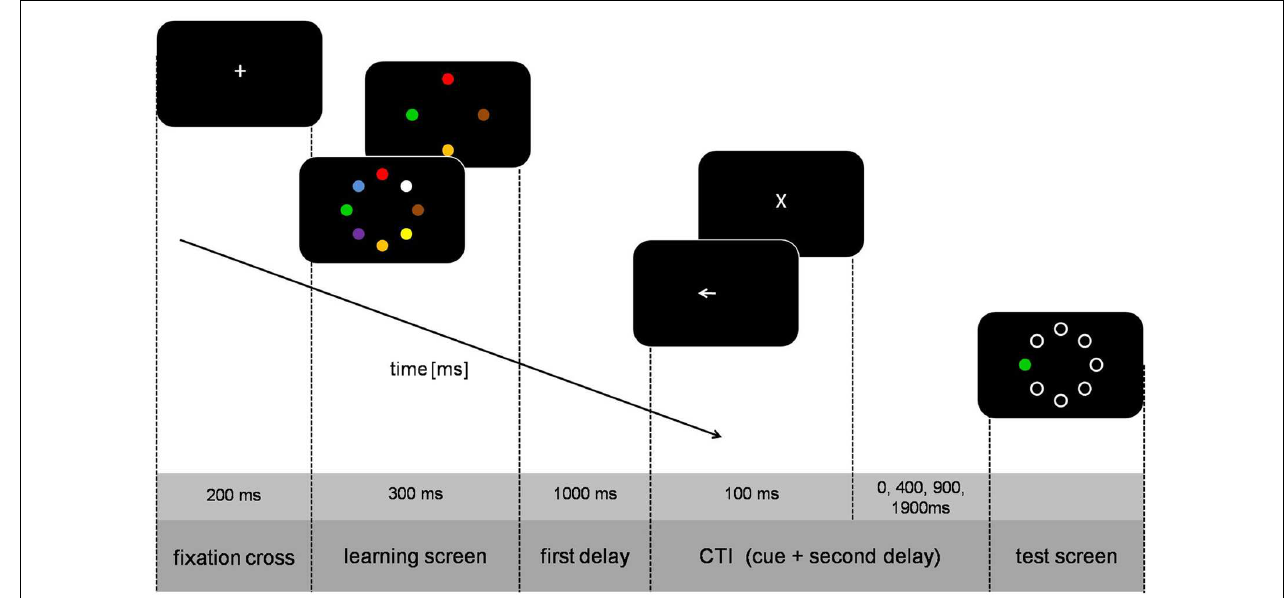
FIGURE 1 | Schematic illustration of trial